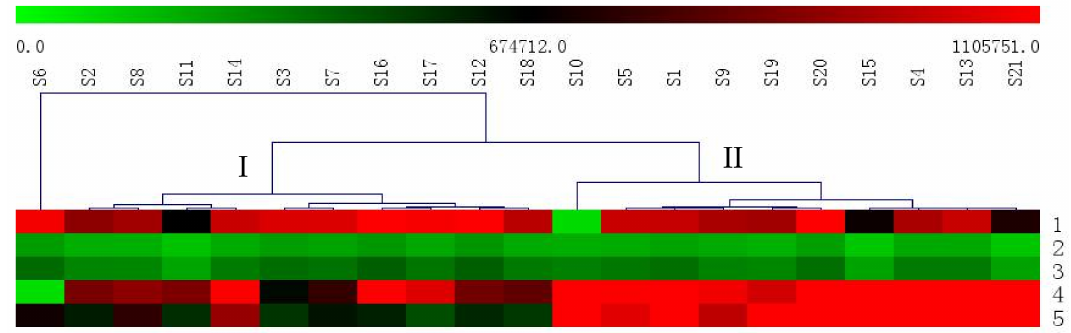
Figure 4. Heat map of the relative concentrations of the five major analytes in all the assessed samples. The S1–21 in the figure represents the samples of different regions of Henan Province. The numbers of 1–5 in the figure represents the five major analytes, including β -ecdysterone (1); 25-S inokosterone (2); 25-R inokosterone (3); ginsenoside R 0 (4); and chikusetsusaponin IVa